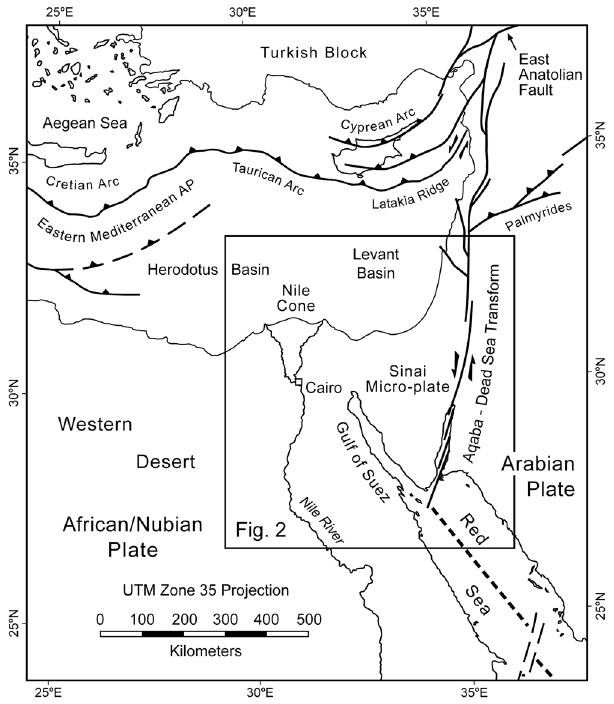
Figure 1. Tectonic setting of the Gulf of Aqaba – Dead Sea sinistral transform fault. Plate boundaries are shown with bold lines 65–67 . AP = accretionary prism. Figure was generated with Macromedia FreeHand MX v11.0.1 (https://www.adobe.com/mena_en/products/freehand/). Location of Fig. 2 is indicated.